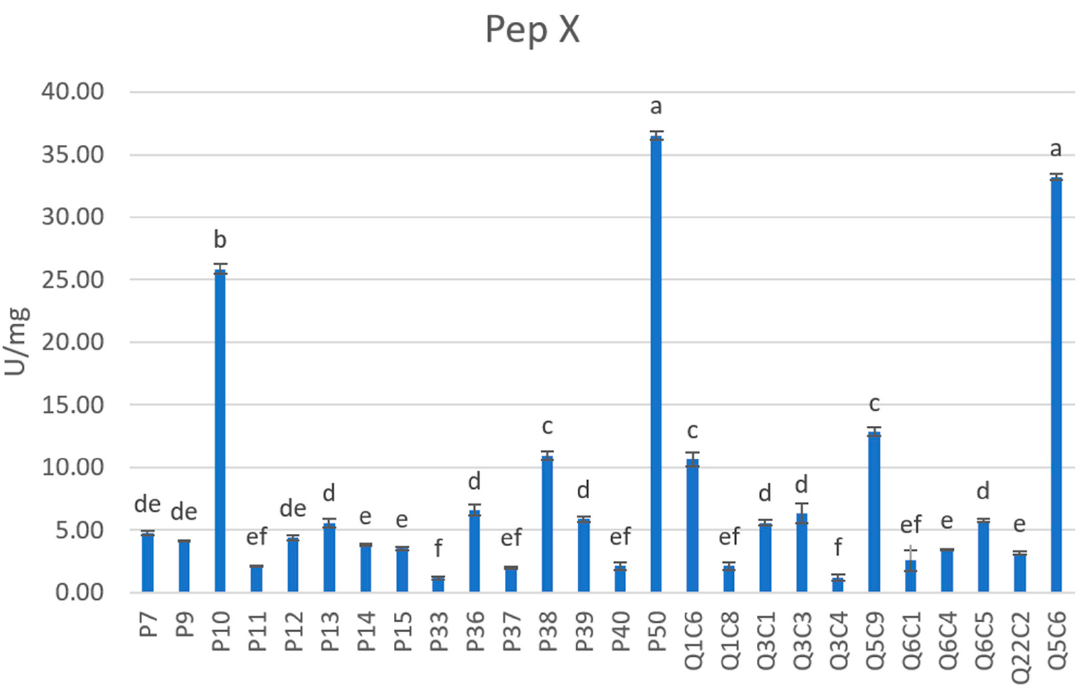
Figure 3. X-prolyl-dipeptidyl aminopeptidase (Pep X) activity exhibited by the tested strains. Results are reported as mean and standard deviation of three replicates. Aminopeptidase activity was expressed as the number of activity units per milligram of protein per minute (U/mg). One unit of aminopeptidase activity was considered as the amount of enzyme required to release 1 µ mol of p-NA per minute under the assay conditions. Different letters (a–f) indicate statistically significant differences as determined by the one-way ANOVA test, which is followed by the Tukey’s post-hoc test ( p <